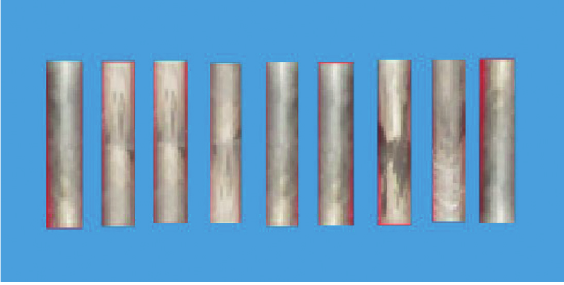
Figure 2: Wear test specimen Table 2: Wear test process parameters and their levels.